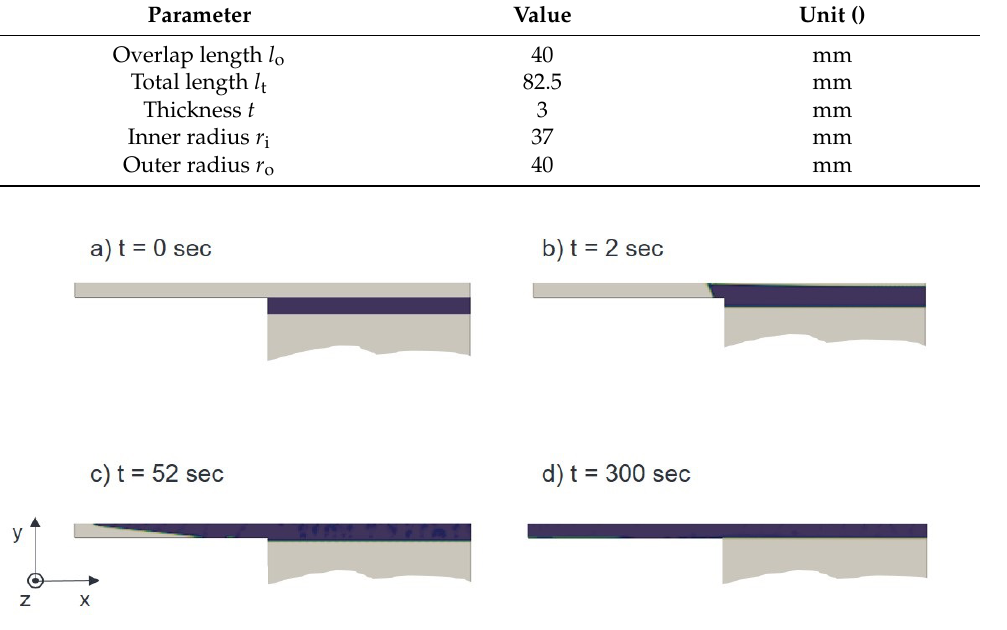
Figure 13. Different stages of impregnation for 60 °C and 1200 RPM.